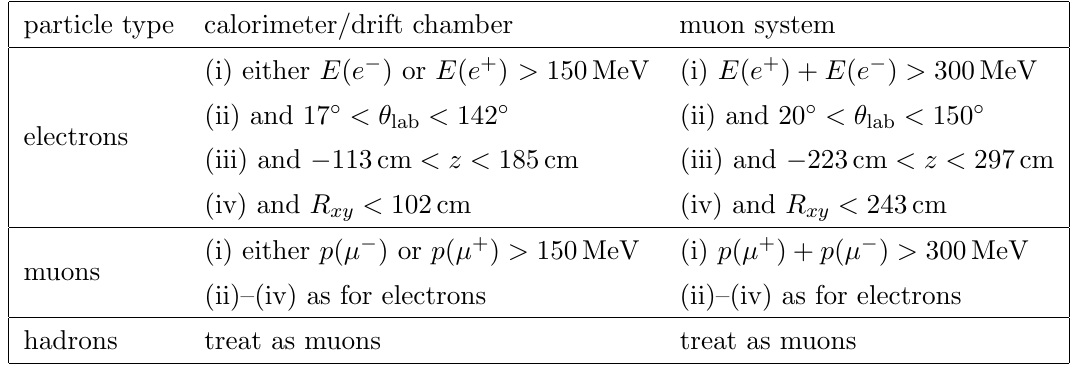
Table 2 . Vetoes on electrons, muons, and hadrons used for the BaBar mono-photon analysis. The variables (cid:18) lab , z , and R xy refer to the (cid:31) 2 decay vertex in the laboratory frame, same de(cid:12)nitions as in table